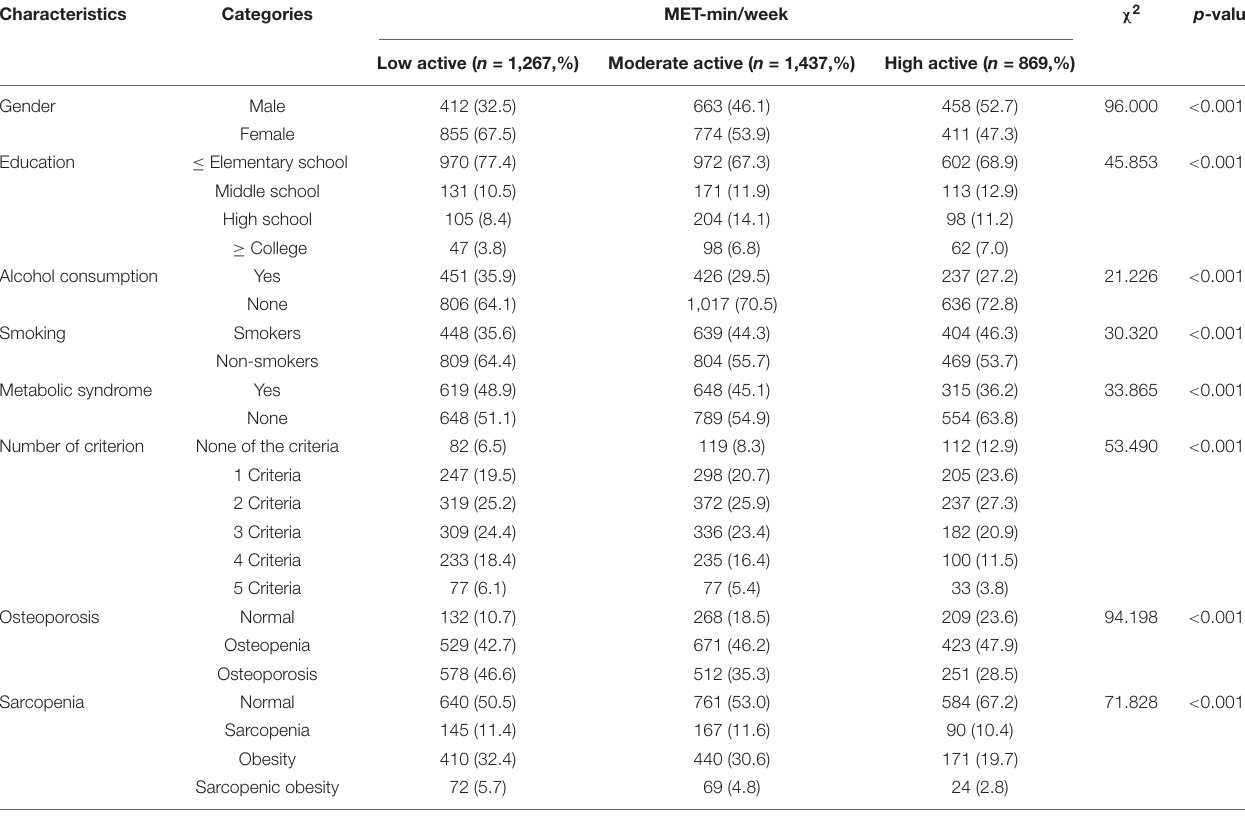
TABLE 2 | Baseline characteristics by physical activity levels status among Korean elderly.